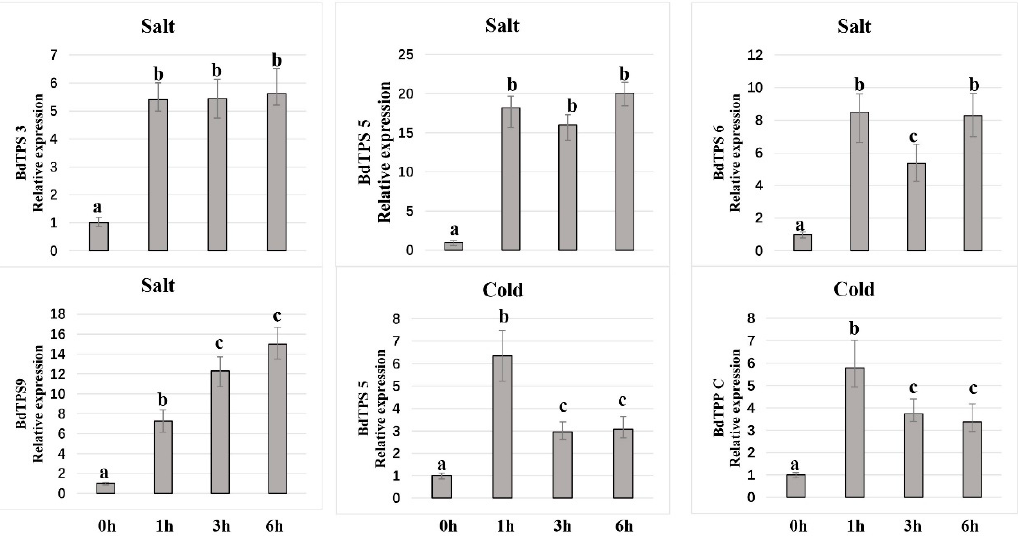
Figure 10. Relative expression level of some BdTPS/BdTPP genes under salt and cold stress conditions at 1, 3, and 6 h after exposure to the abiotic stress. Different lowercase letters (a, b, c) above the bars indicate significantly different values ( P < 0.05, t -test).